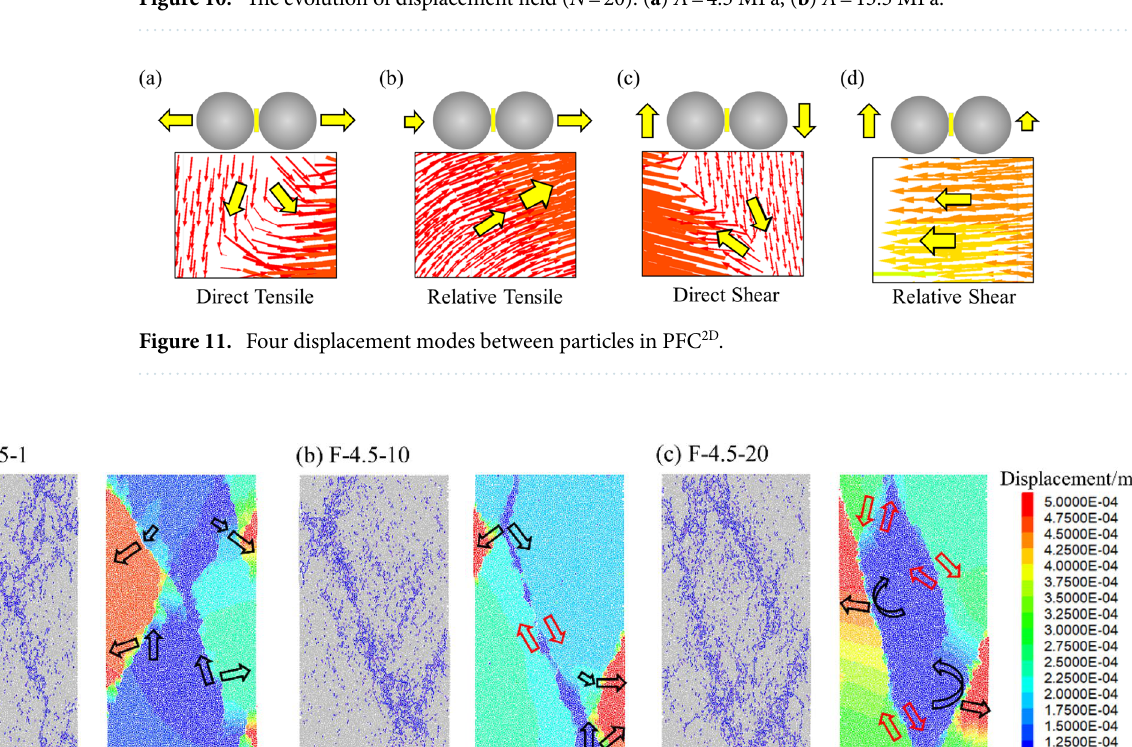
Figure 10. The evolution of displacement field ( N = 20): ( a ) A = 4.5 MPa; ( b ) A = 13.5 MPa.